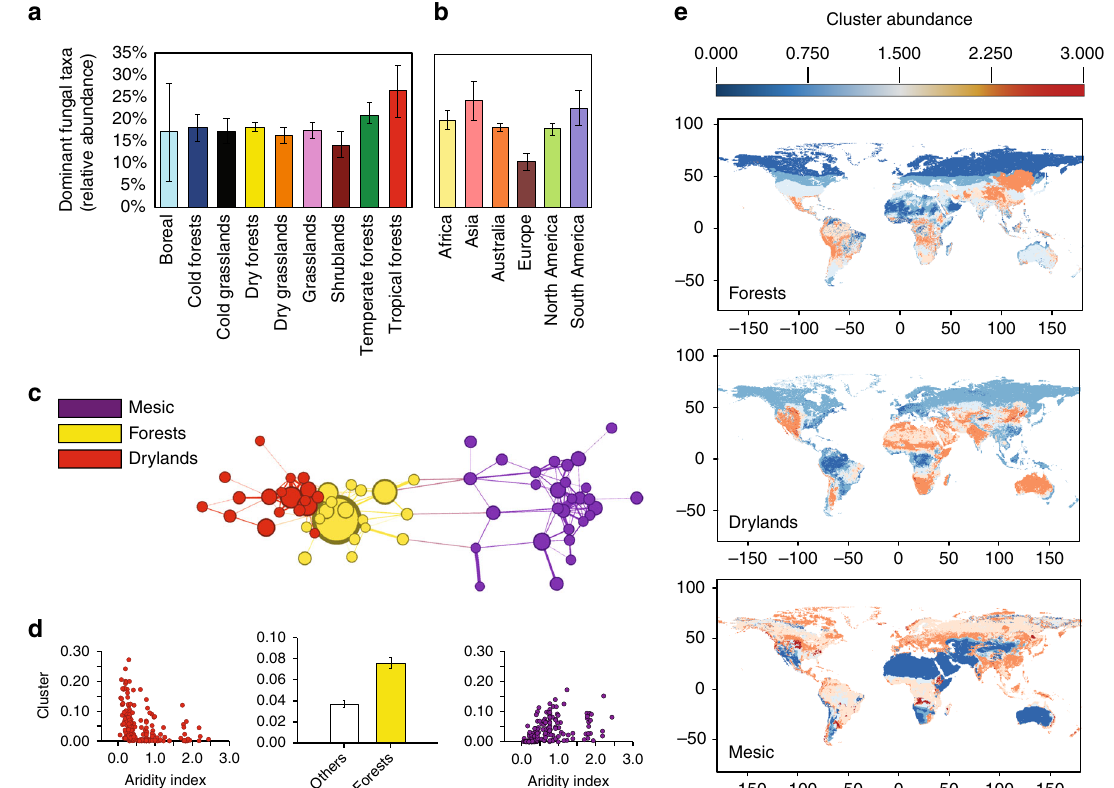
Fig. 2 Distribution and habitat preferences for dominant fungal phylotypes. Relative abundance (mean ± SE) of dominant phylotypes across ( a ) boreal ( n = 3), cold forests ( n = 18), cold grasslands ( n = 22), dry grasslands ( n = 42), dry forests ( n = 60), grasslands ( n = 41), shrublands ( n = 15), temperate forests ( n = 27), and tropical forests ( n = 7), and ( b ) continents. Biome classi fi cation followed the Köppen climate classi fi cation and the major vegetation types found in our database. Grasslands include both tropical and temperate grasslands. Shrublands include polar, temperate, and tropical shrublands. c Network diagram with nodes (fungal phylotypes) coloured by each of the three major ecological clusters (i.e., mesic in purple, forests in yellow, drylands in red) that were identi fi ed, highlighting that phylotypes within each ecological cluster tend to co-occur more than expected by chance. d Relationships between the relative abundance of the phylotypes assigned to each ecological cluster and their major environmental predictors. e Predicted global distribution of the relative abundances of the three major ecological clusters of fungal phylotypes sharing habitat preferences for drylands, forests and mesic ecosystems. We found a positive (Spearman) correlation between predicted and observed data for drylands ( r = 0.47; p < 0.001), forests ( r = 0.32; p < 0.001) and mesic ( r = 0.61; p < 0.001) ecosystems. The scale bar represents the standardised abundance ( z -score) of each ecological